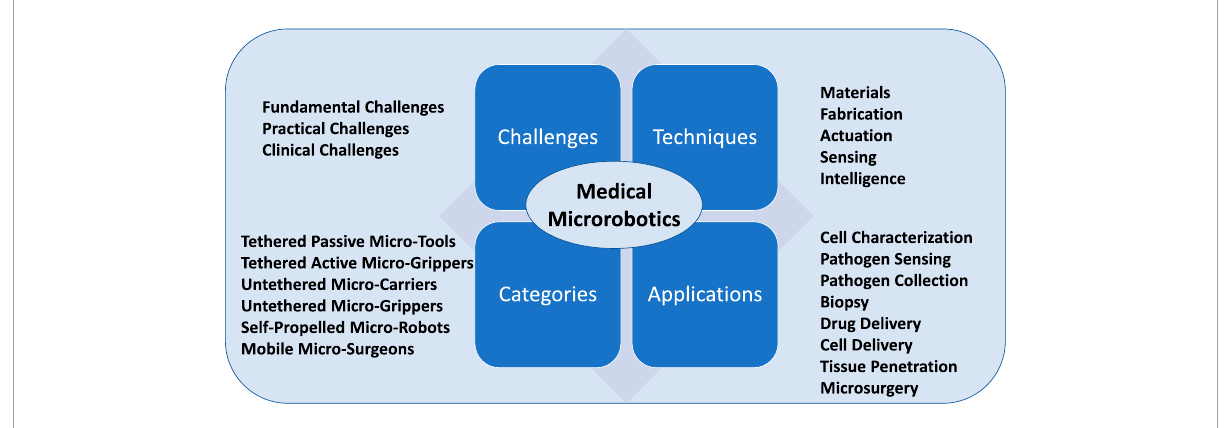
FIGURE 1 Conceptual overview of this article. Key challenges, techniques, development tendencies and applications of micro-robotics for biomedical research are